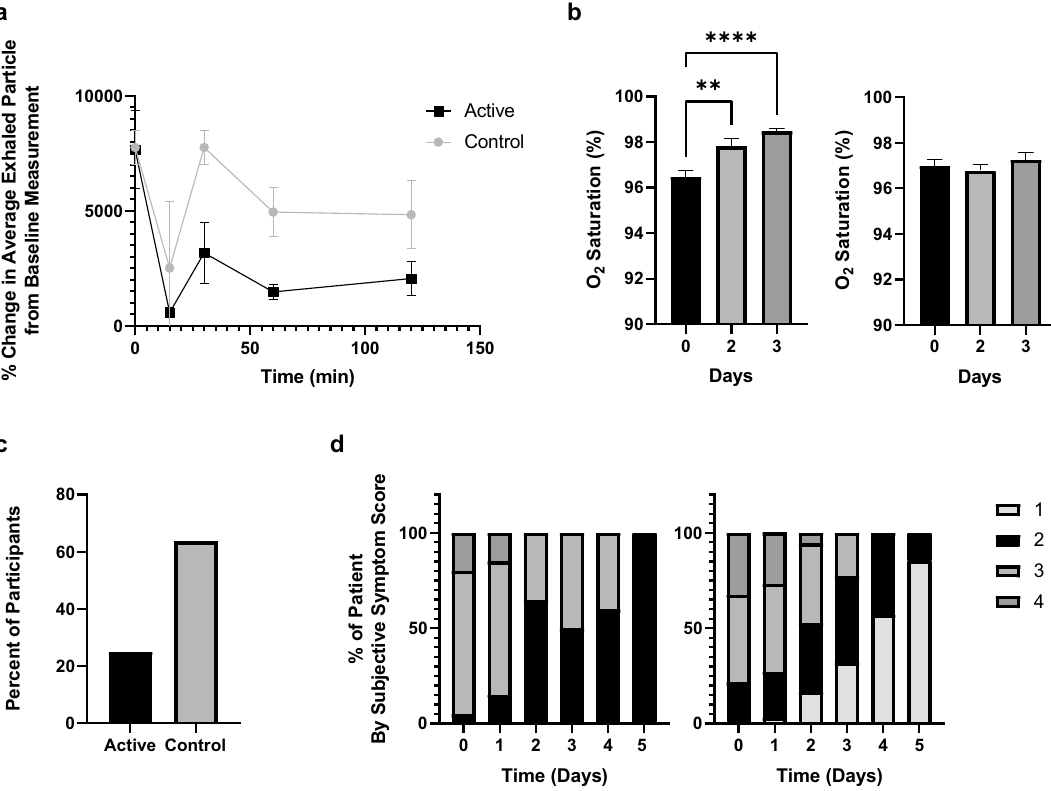
Figure 4. Drug intervention and COVID-19 symptom measures following administration of FEND or the Simply Saline control. ( A ) Exhaled aerosol particle numbers from 39 mildly symptomatic COVID-19 subjects following administration of hypertonic calcium-rich salts targeting the upper airways (active—FEND), and 39 mildly symptomatic COVID-19 subjects following administration of nasal saline spray (Simply Saline—control); ( B ) Oxygen saturation levels as a function of days of administration of FEND (left, n = 17)) and Simply Saline (right, n = 20) control; ( C ) % intravenous antibiotic or steroid intervention required among those subjects with high inflammation in the FEND cohort (9 of 20 subjects) and in the Simply Saline cohort (9 of 19 subjects); ( D ) Self-reported symptom scores (on scale 1 to 5, with 1 = no symptoms, and 5 = most severe symptoms) as a function of days of hospitalization and administration over the first three days of FEND (right) and Simply Saline control (left). Error bars represent standard errors of the mean. **P < 0.0025, ***P <